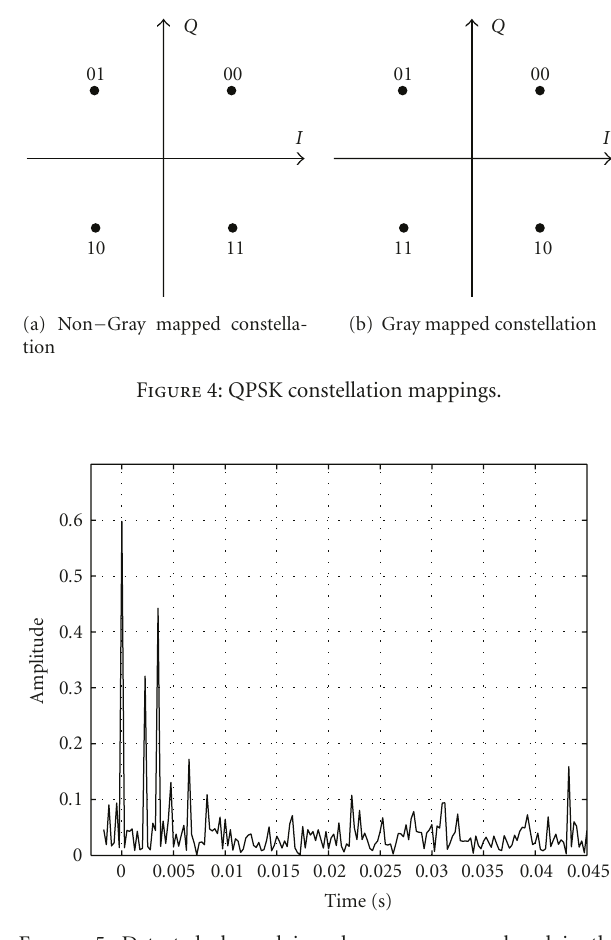
Figure 5: Detected channel impulse response employed in the simulation.